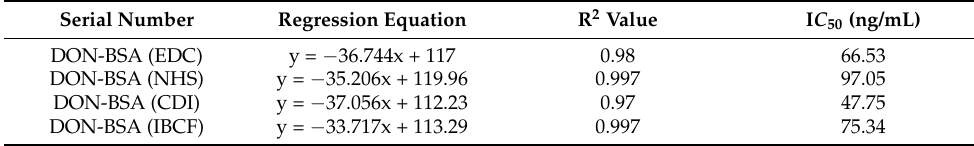
Table 2. Regression equation, R 2 , and I C 50 for DON pAb.